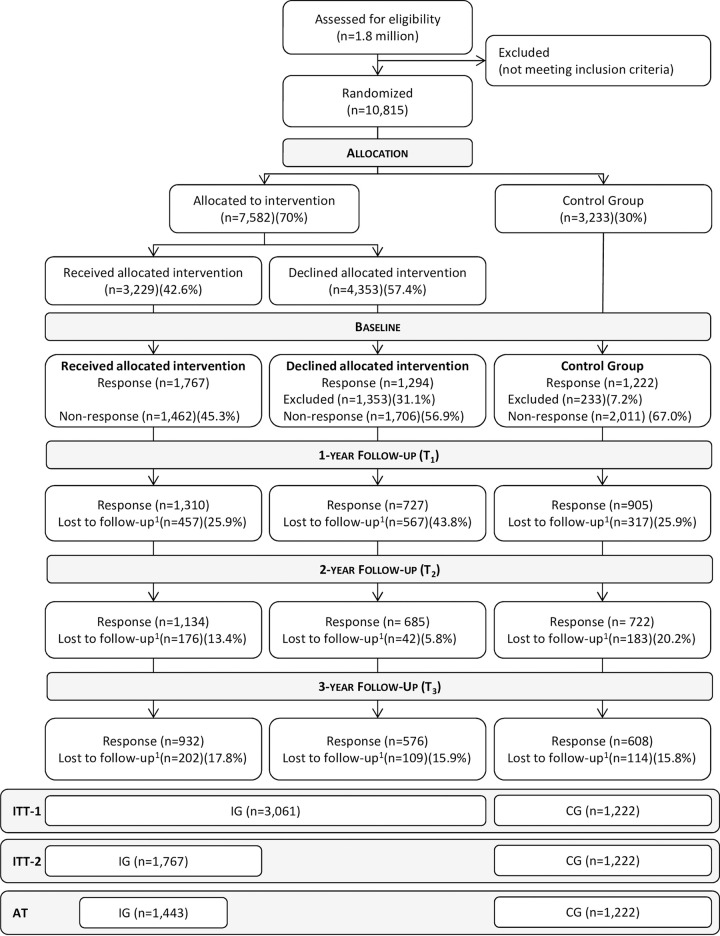
CONSORT participant flow chart.1 = due to non-response / can include death; ITT-1 = intention-to-treat analysis 1 (n = 4,283); ITT-2 = intention-to-treat analysis 2 (n = 2,989); AT = as treated analysis (n = 2,665).